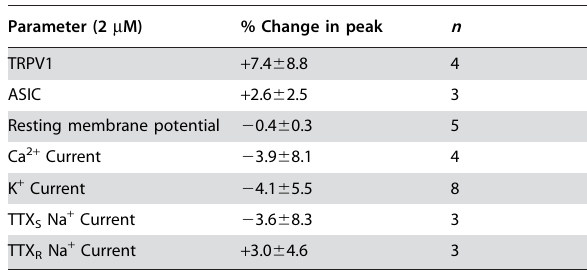
Table 1. NMB-1 is selective for MA currents in DRG neurons. ... ... ... .... ... ... .... ... ... .... ... ... .... ... ... .... ... ... .... ... ... . Parameter (2 m